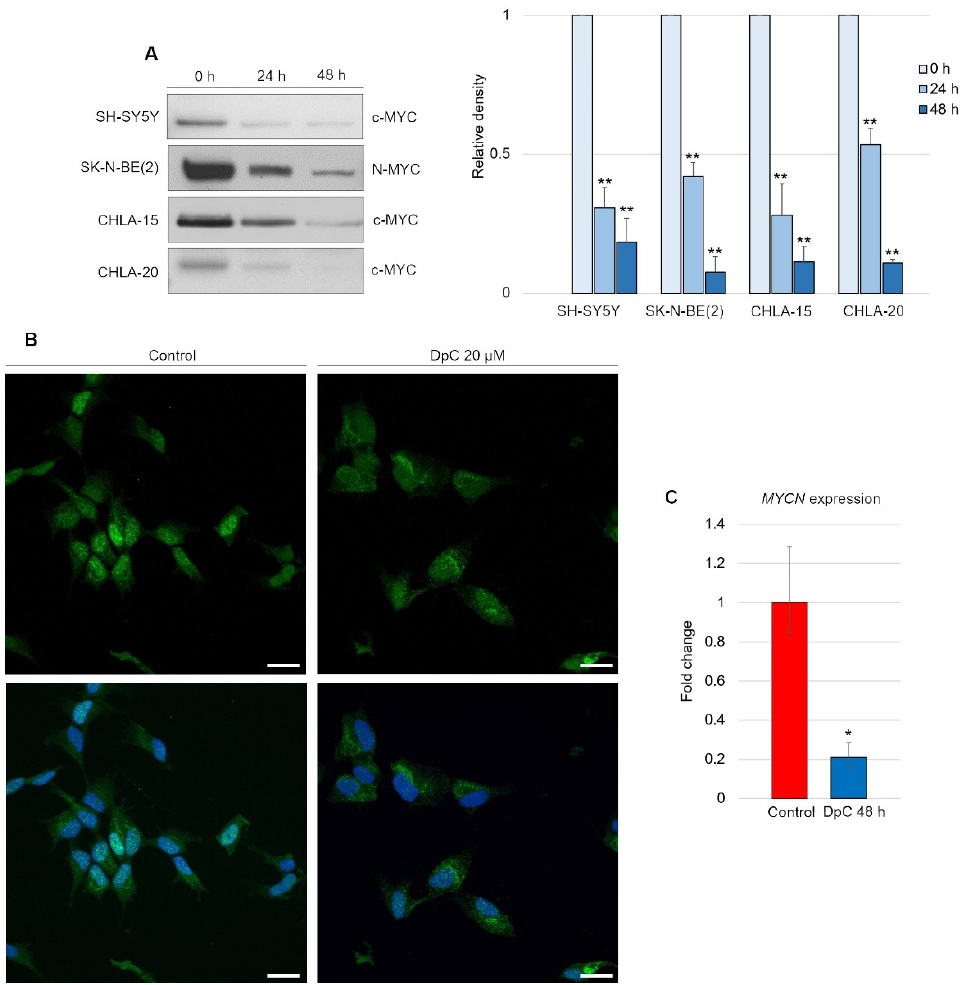
Figure 7. DpC downregulates MYC proteins in neuroblastoma cell lines. ( A ) Immunoblotting of c-MYC (SH-SY5Y, CHLA-15, CHLA-20) and N-MYC (SK-N-BE(2)) protein levels in neuroblastoma cells treated with 20 μ M (SH-SY5Y) or 2 μ M (CHLA-15, CHLA-20) DpC. Representative images (left) and relative optical density values (right) of three independent experiments. Source data are provided in Figure S1. Densitometry data are shown as the mean ± SD normalized to 0 h values. * p < 0.05; ** p < 0.01; two-tailed unpaired t -test. ( B ) Immunofluorescence micrographs of c-MYC (green) in SH-SY5Y cells treated with 20 μ M DpC and EGF (40 ng/mL; 10 min; 37 °C). Nuclei counterstained with Hoechst 33342 (blue). Scale bar = 20 μ m. ( C ) qRT–PCR analysis of the effect of 20 μ M DpC on the expression of MYCN in the SK-N-BE(2) cell line. Fold change ± SD comprised of three independent experiments. * p < 0.05; ** p < 0.01; two-tailed unpaired t -test.